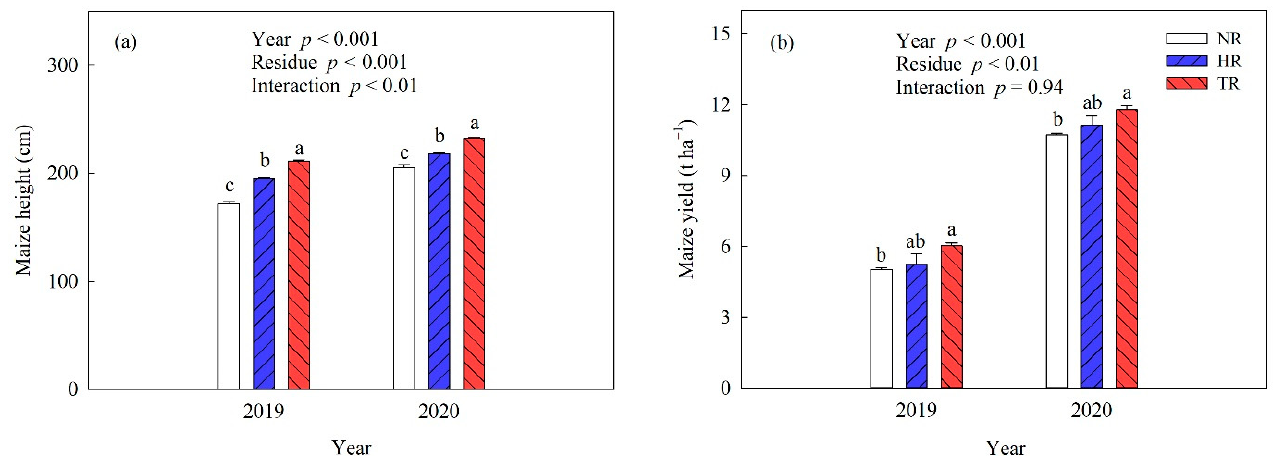
Figure 4. Plant height ( a ) and grain yield ( b ) of maize under treatments (NR, no crop residues retention; HR, half crop residues retention; TR, total crop residues retention) during the study period. Different letters indicate significant differences at the 0.05 level between the treatments. Bars represent means ± SE. Statistical results above the bars show the linear mixed-effects model.